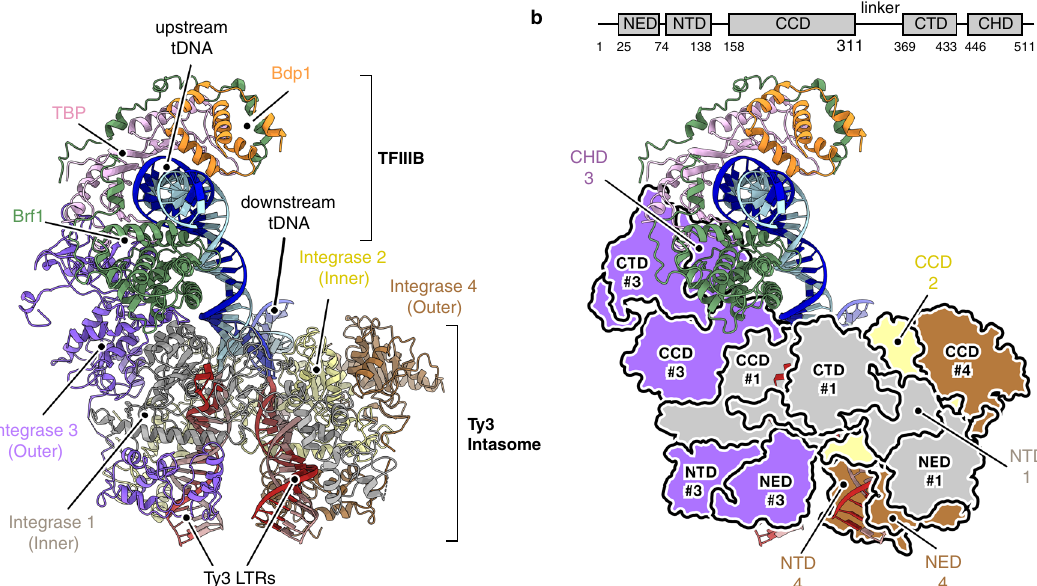
Fig. 2 Cryo-EM structure of Ty3 strand-transfer complex bound to TFIIIB transcription factor and tD(GUC)K tRNA gene. a Ribbon representation (front view) of Ty3 retrotransposon strand-transfer complex (STC) bound to TFIIIB transcription factor and the t(GUC)K gene. Four integrase molecules are numbered and coloured in grey, yellow, purple and brown. Brf1, TBP and Bdp1 subunits of TFIIIB are depicted in green, pink and orange, respectively. Template and non-template strands of the tDNA are shown in dark and light blue, respectively. Ty3 long-terminal repeats (LTRs) are highlighted in red shades. b Ty3 retrotransposon model representing as silhouettes the domain architecture of Ty3 integrase subunits (inset). NED N-terminal extended